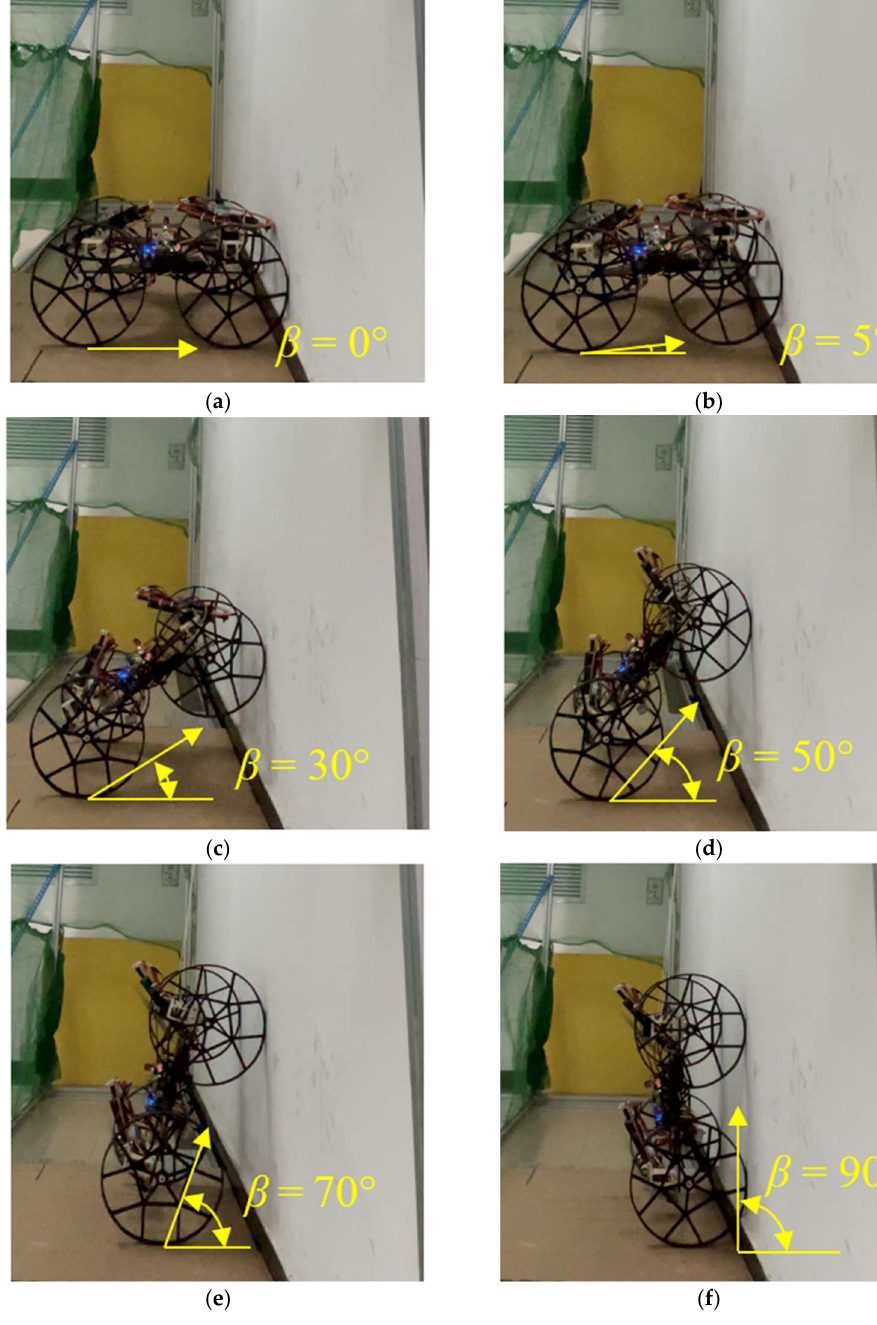
Figure 12. Ground-wall transition experiment of DP-Climb: ( a ) β = 0°; ( b ) β = 5°; ( c ) β = 30°; ( d ) β = 50°; ( e ) β = 70°; ( f ) β = 90°. ( d ) β = 50 ◦ ; ( e ) β = 70 ◦ ; ( f ) β = 90 ◦